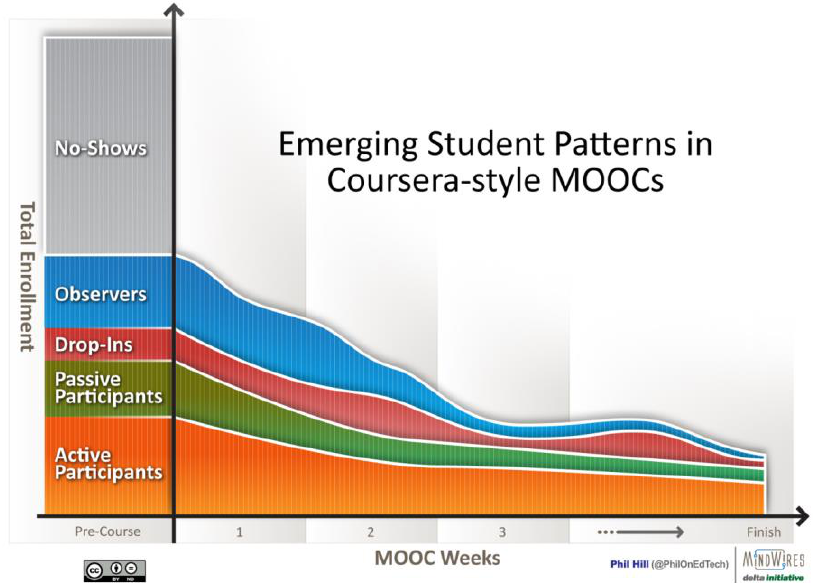
Figure 1. Hill’s MOOC participant typology. From “Emerging patterns in MOOCs: A graphical view.” P. Hill, E-literate, 2013 . (mfeldstein.com/emerging_student_patterns_in_moocs_graphical_view/)